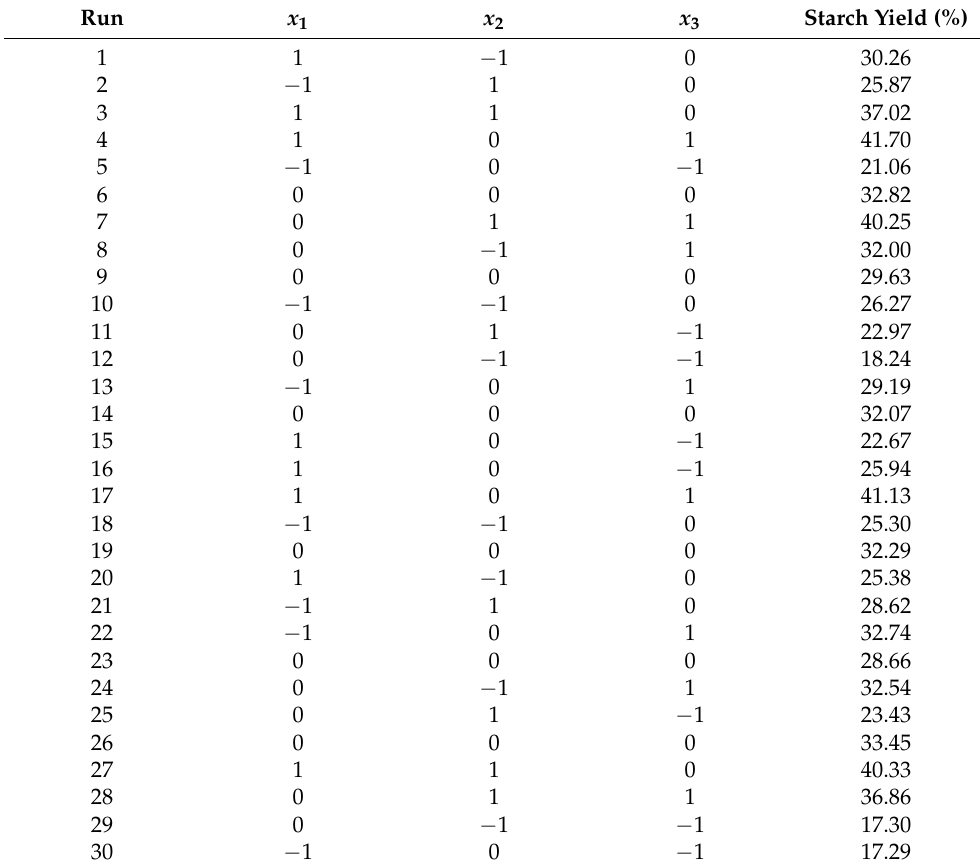
Table 2. Box-Behnken design with the observed